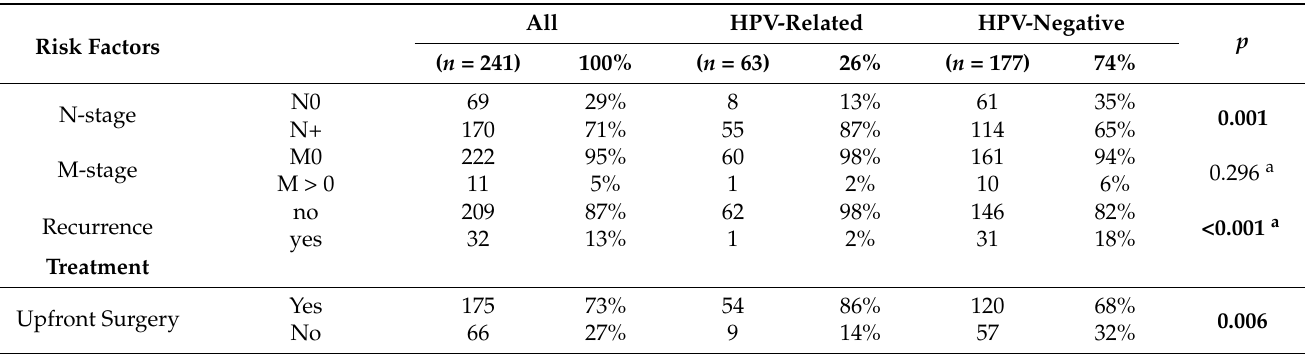
Illustrative images of the staining patterns of LAG-3, TIM-3, and VISTA on immune cells are displayed in Figure 1A–D.